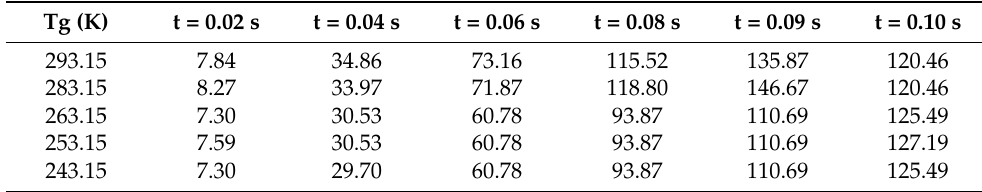
Table 2. Deformation factor A of a falling water droplet (10 − 4 ).